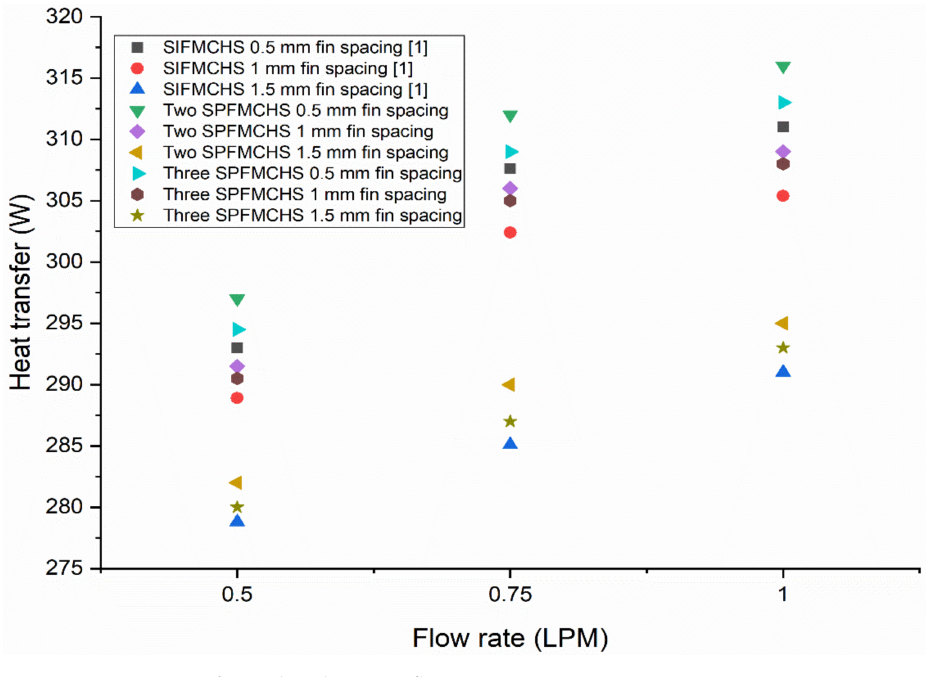
Figure 11. Heat transfer with volumetric flow rate.